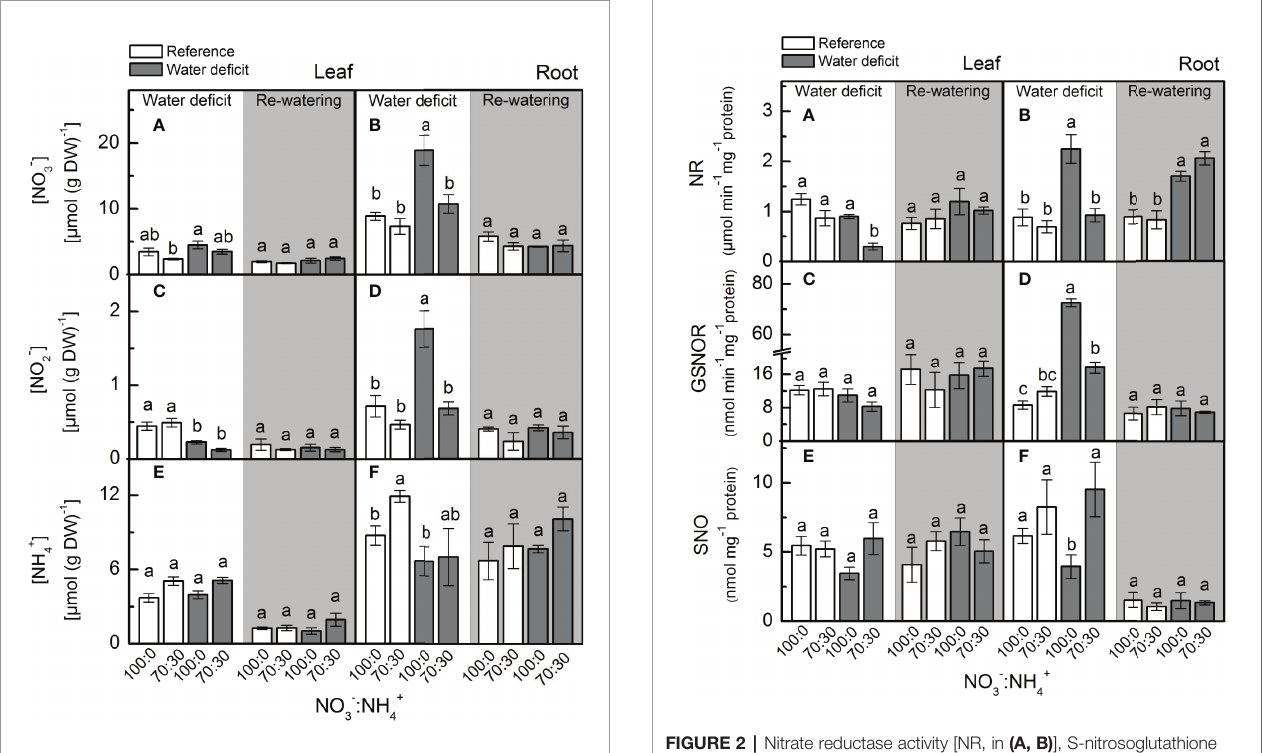
FIGURE 1 | Concentration of nitrate (A , B) , nitrite (C , D) and ammonium (E , F) in leaves (A , C , E) and roots (B , D , F) of sugarcane plants maintained well- hydrated (reference, white bars) or subjected to water de fi cit (gray bars) and supplied with varying NO 3 − :NH 4+ ratios: 100:0 and 70:30. The white area indicates the period of water de fi cit, and the shaded area indicates the period of re-water. Bars represent the mean value of four biological replicates ± se. Different letters indicate statistical difference (BF 10 > 3) among treatments in a given evaluation.